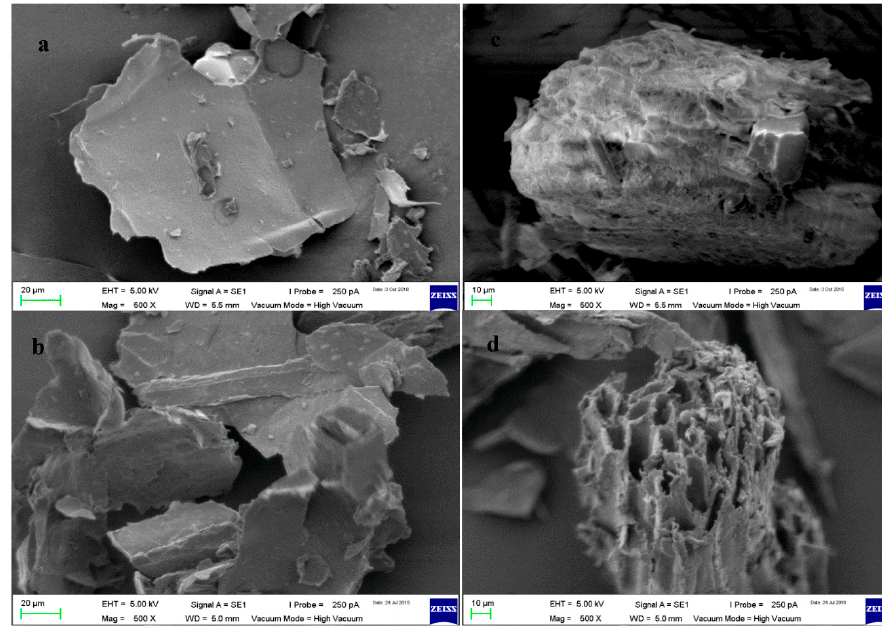
Figure 3. ( a ) Magnification of fiber structure for RSCB. ( b ) Magnification of pith structure for TSCB. ( c ) Magnification of pith structure for RSCB. ( d ) Magnification of pith structure for TSCB.